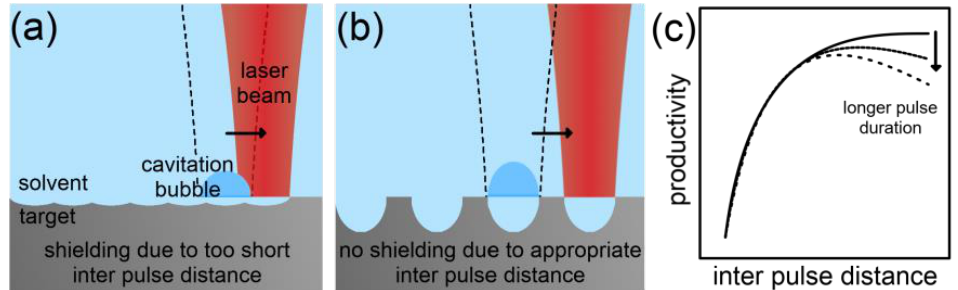
Figure 10. Illustration of a too short ( a ) and an appropriate ( b ) interpulse distance in the laser ablation of metals in liquids. The diagram in ( c ) demonstrates relative effects of different laser pulse durations on the dependence of the productivity on the inter-pulse distance. In ( c ), both axes scale linearly. The trends shown in the diagram represent the interpretation of the combined results of the discussed literature in Section 2.2.1. In ( c ), the arrow and the less dense line style indicate the effect of a longer laser pulse duration on productivity. Reprinted with permission from [66].